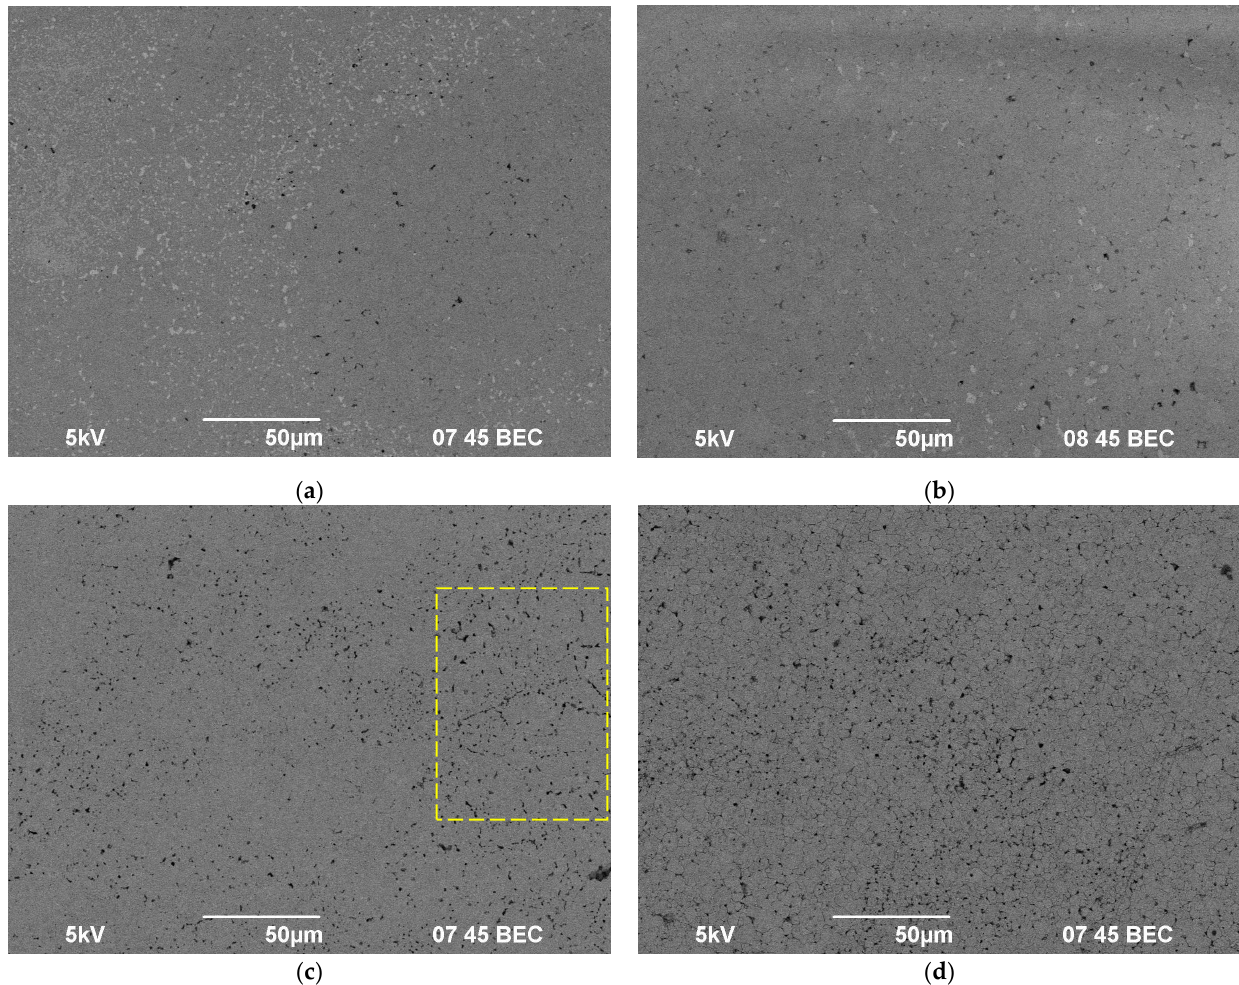
Figure 3. SEM images of the ceramic samples surface after hydrolytic tests for 1000 h at room temperature ( a ) at 100 °C ( b ) at 200 °C ( c ) and at 300 °C ( d ).